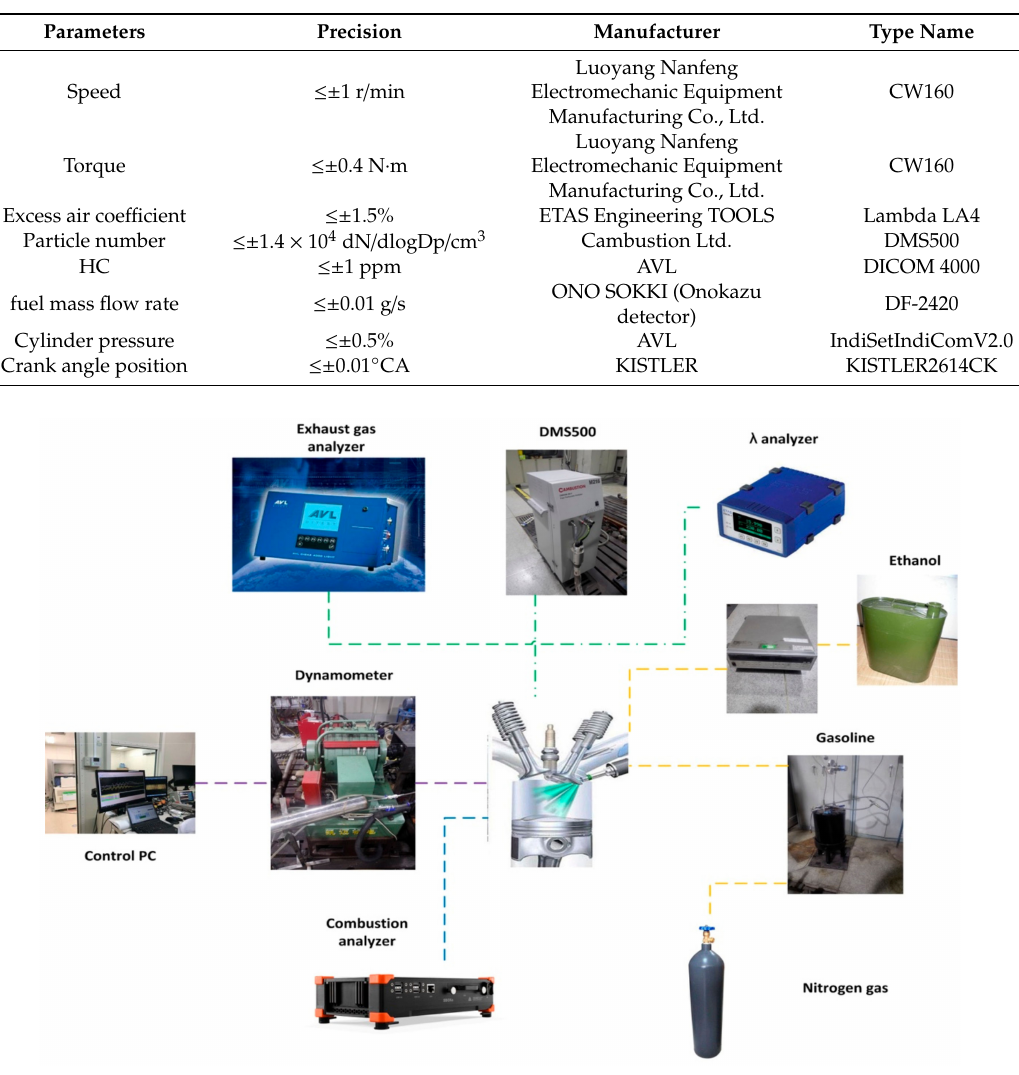
Table 2. Technical parameter of the experimental instrument.